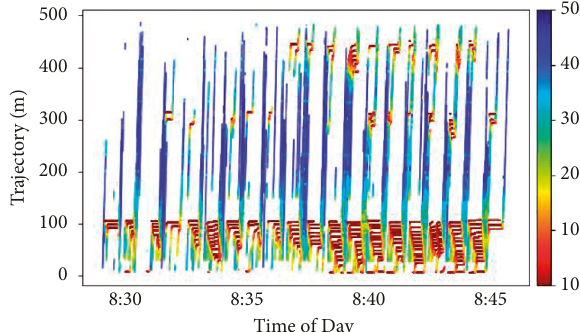
Figure 2: Trajectory of Lankershim Street,